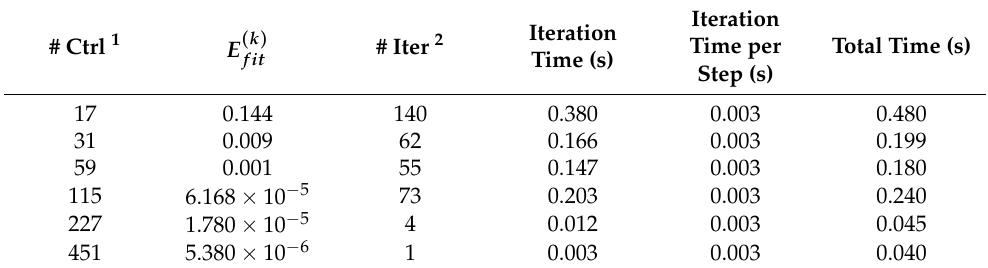
Table 1. Experimental data of Incre-IG-LSPIA algorithm with five times knot refinement. The number of collocation points is m = 600.